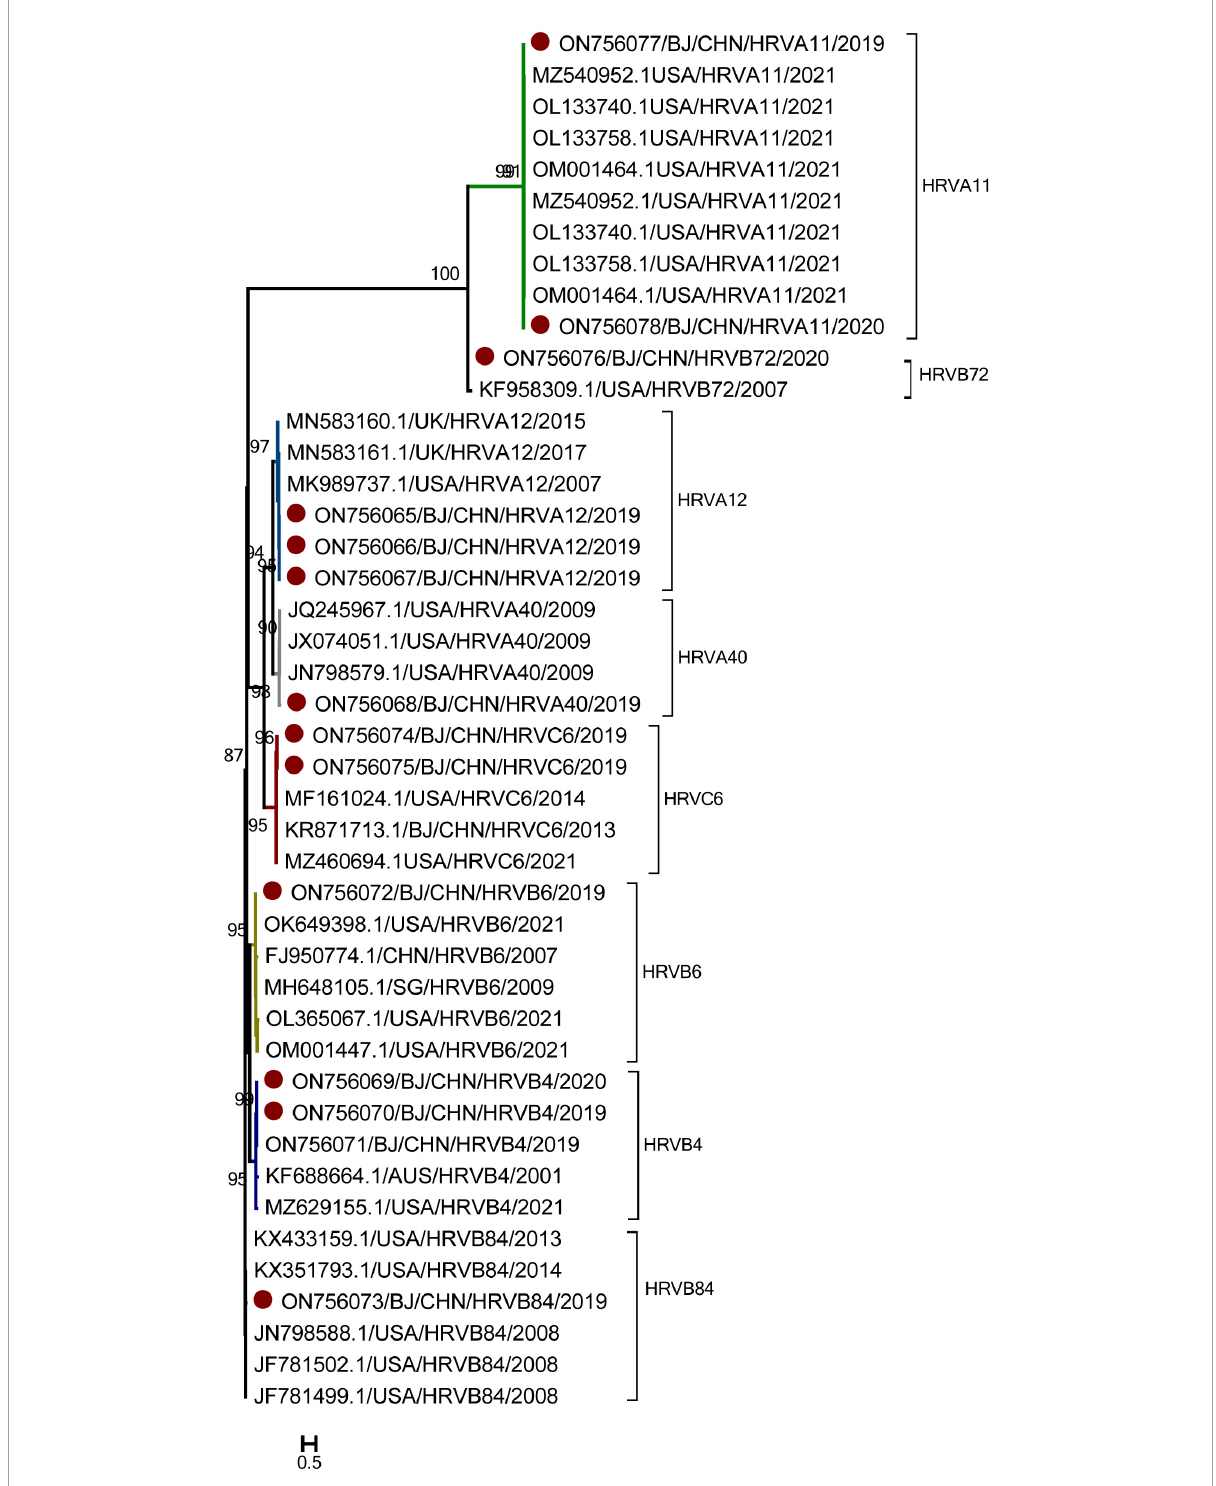
FIGURE4 The phylogenetic tree of human rhinovirus (HRV) strains based on VP4 to VP2 gene region. The phylogenetic relationships were estimated by the maximum-likelihood method with GTR + G + I model. HRV strains detected in this study were marked with the symbol: • . Bootstrap values, estimated from 1,000 replicates, are indicated at each node. The scale bar indicates the number of nucleotide substitutions per